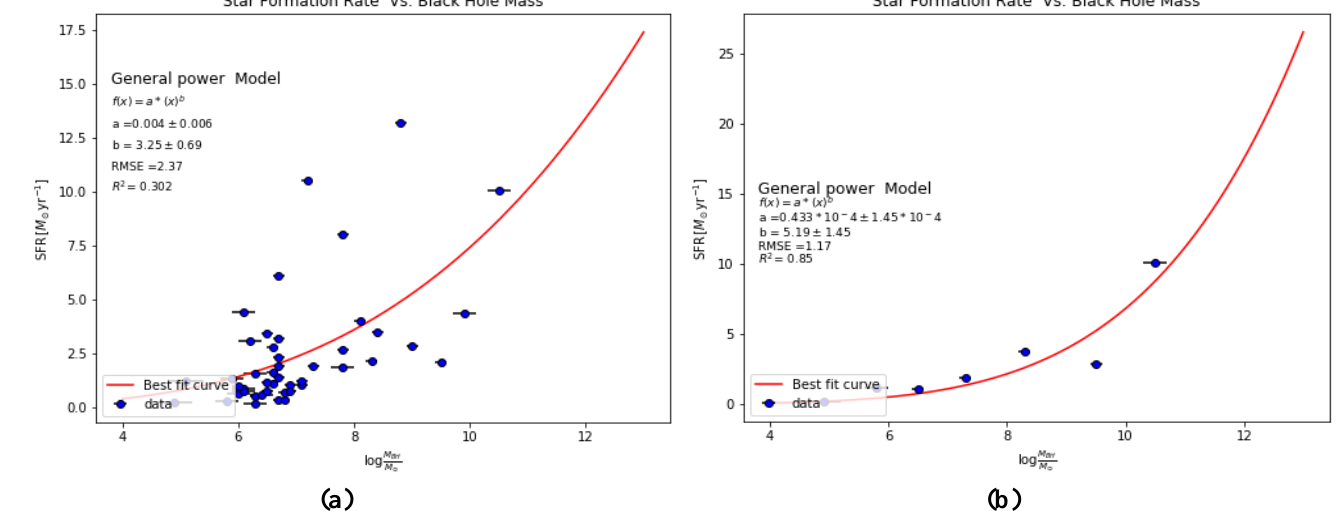
Fig.8: The correlation between the SMBH & SFR for seyfert2 galaxies using power regression, where (a) for all samples, (b) median